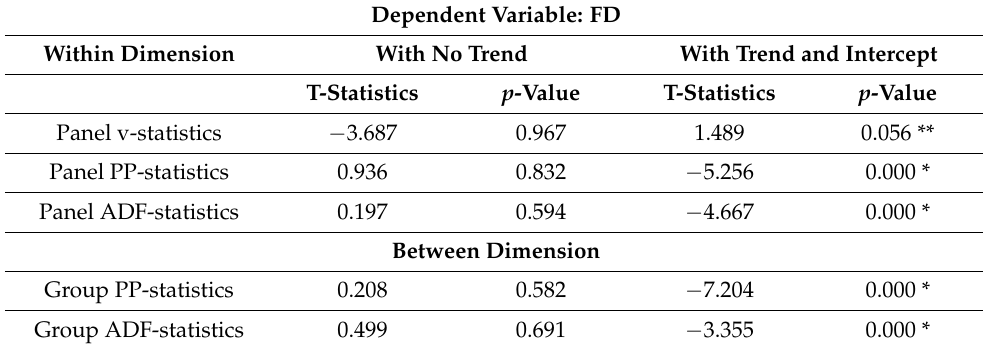
Table 3. Pedroni cointegration